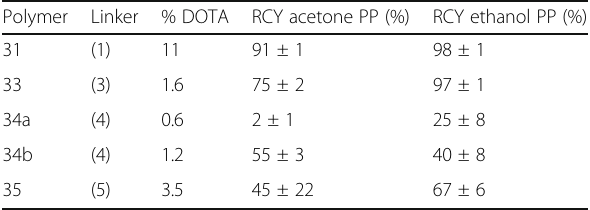
Table 3 Labeling of HPMA-DOTA conjugates 31 – 35 using acetone and ethanol post-processed 68 Ga eluate (20 nmol, 20 min, 95